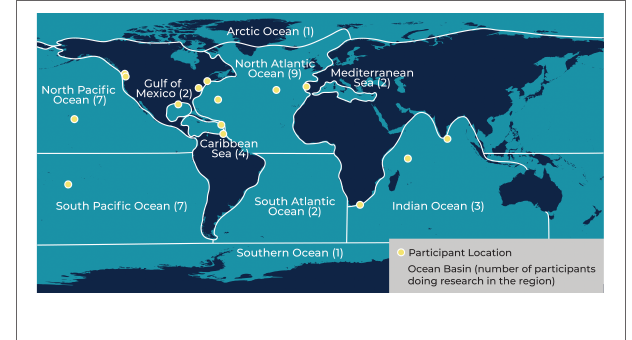
FIGURE 2 | Nineteen out of twenty interviewees self-reported their location of residence (yellow dot) and fieldwork location(s) (ocean basins). Locations of residence include Bermuda (2), Canada, Cook Islands, Montserrat, Portugal (2), Seychelles, South Africa, Sri Lanka, Trinidad and Tobago, and the United States (8). Many participants conduct fieldwork in different ocean basins from their home